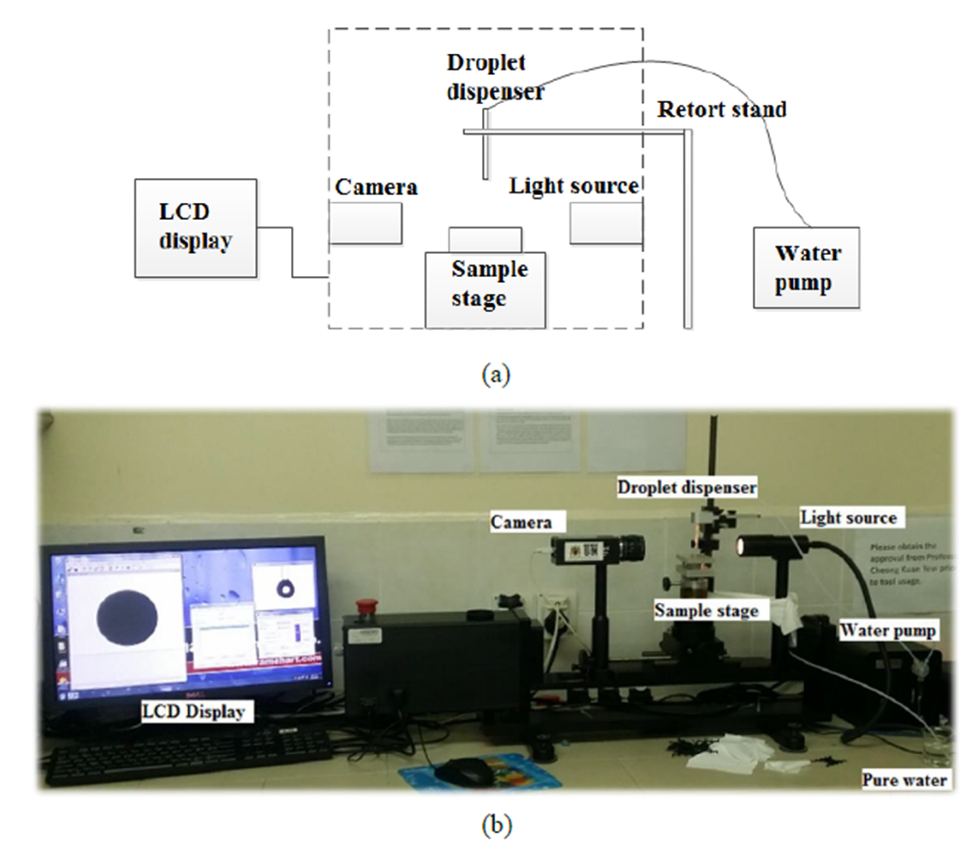
Figure 6. Contact angle measurement setup: ( a ) schematic diagram and ( b ) image of actual measure- ment